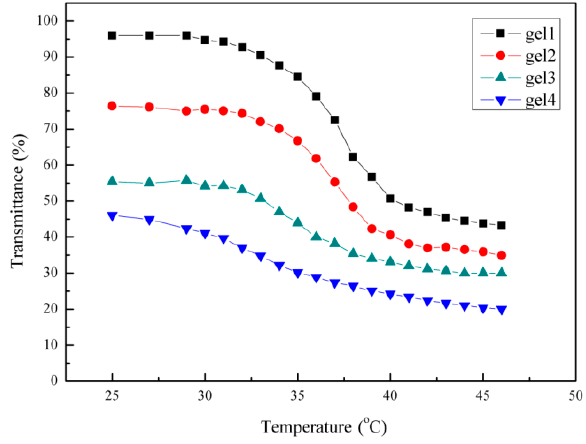
Figure 6. The light transmittance of gel1-4 (2 mg/mL) changes with temperature.